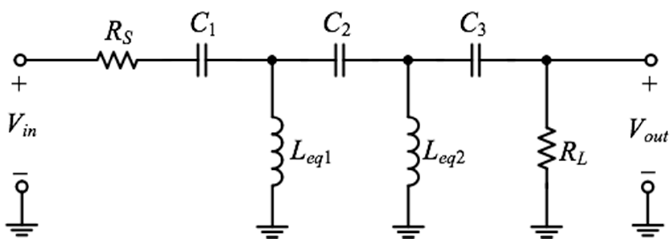
Figure 9. Standard fifth-order high-pass ladder filter realization [49].